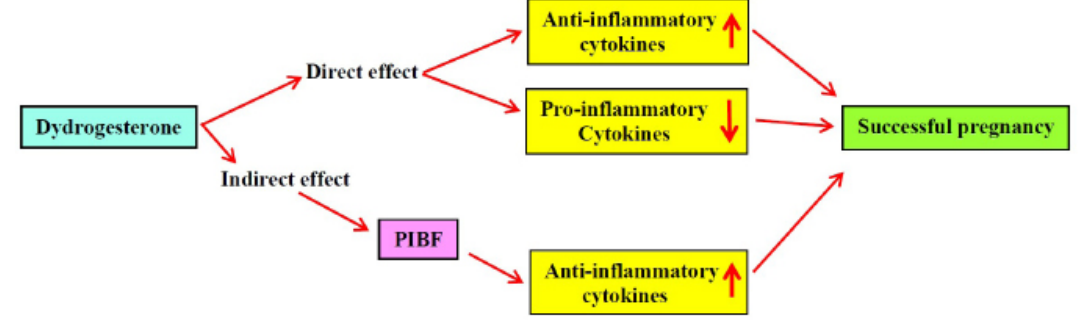
Figure 1. Immunomodulatory mechanisms of action of dydrogesterone PIBF: an